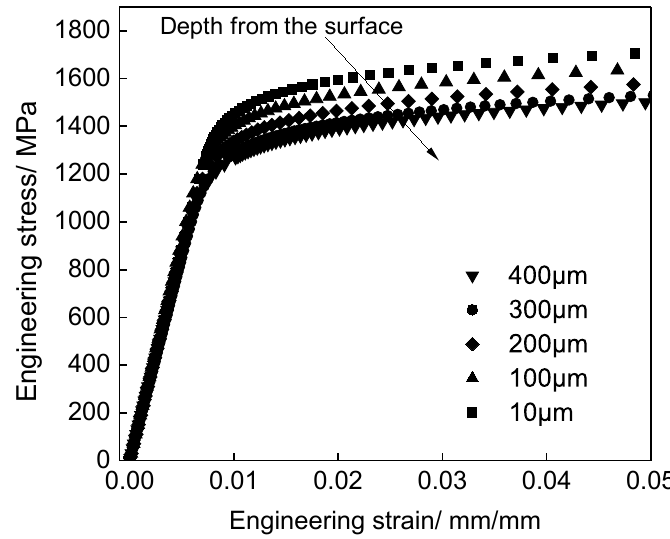
Figure 11. The derived material stress–strain relationship at different